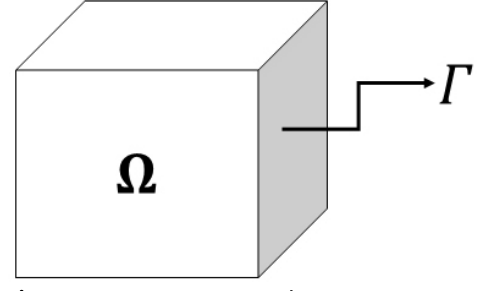
Figure 1. The problem